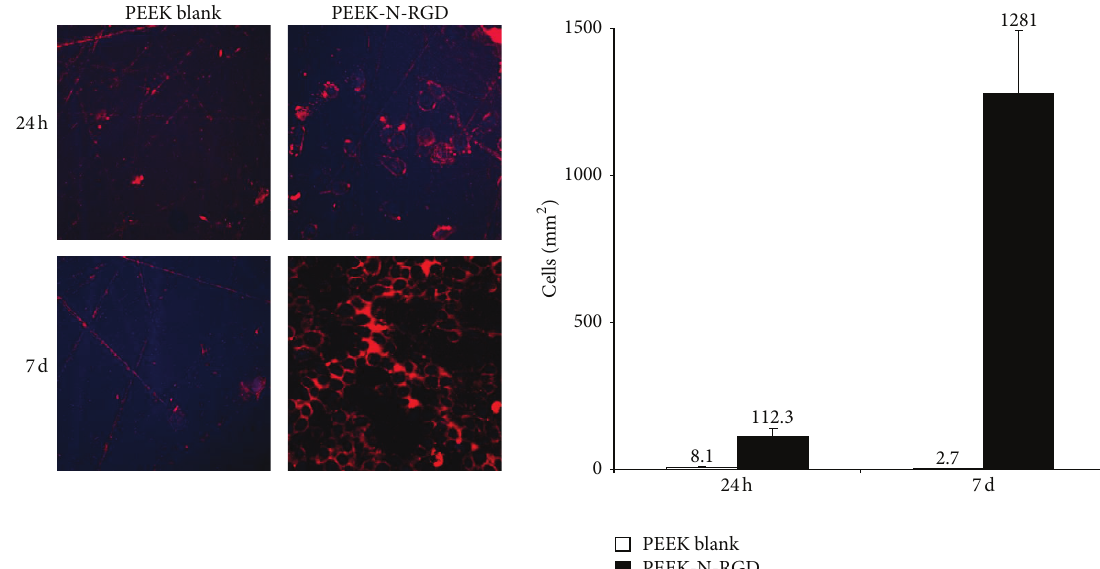
Figure 3: Adhesion and growth of primary human osteoblasts on bare and RGD-modified PEEK surfaces. Cells were cultured for 24 h or 7d. After cultivation, cell coverage was analyzed by fluorescence microscopy. Results from triplicate determinations are expressed as mean ± SD (magnification × 100, bar = 20 𝜇